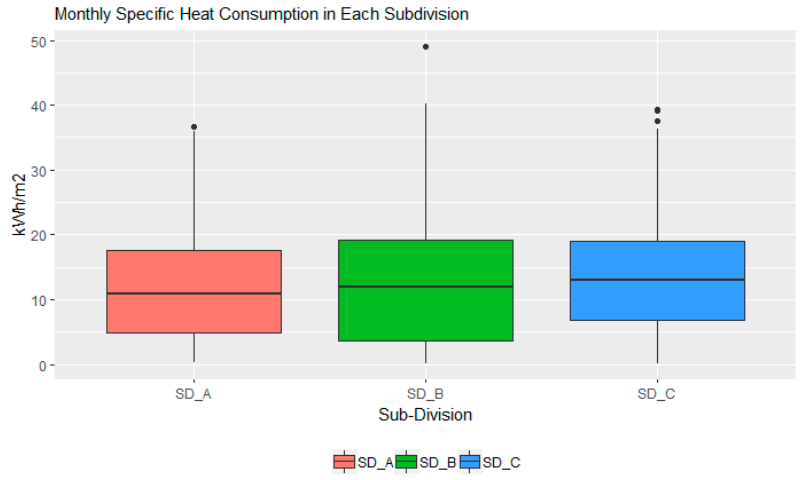
Figure 6. Boxplots of the monthly specific heat consumption in each subdivision.